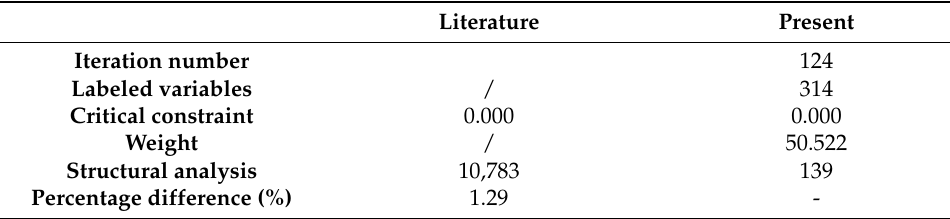
Table 5. Optimization results of the 662-bar truss.